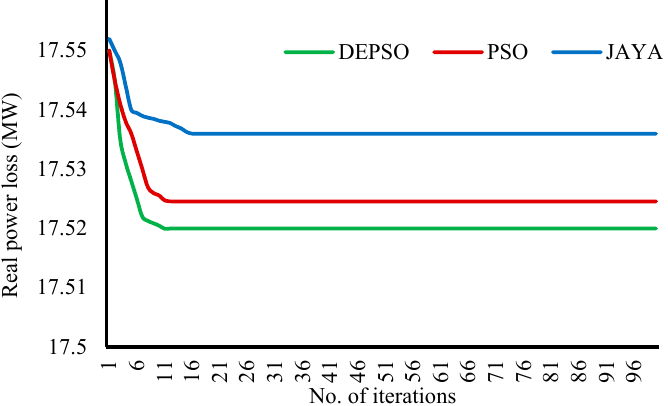
Figure 7. Convergence plot for IEEE 30-bus system.